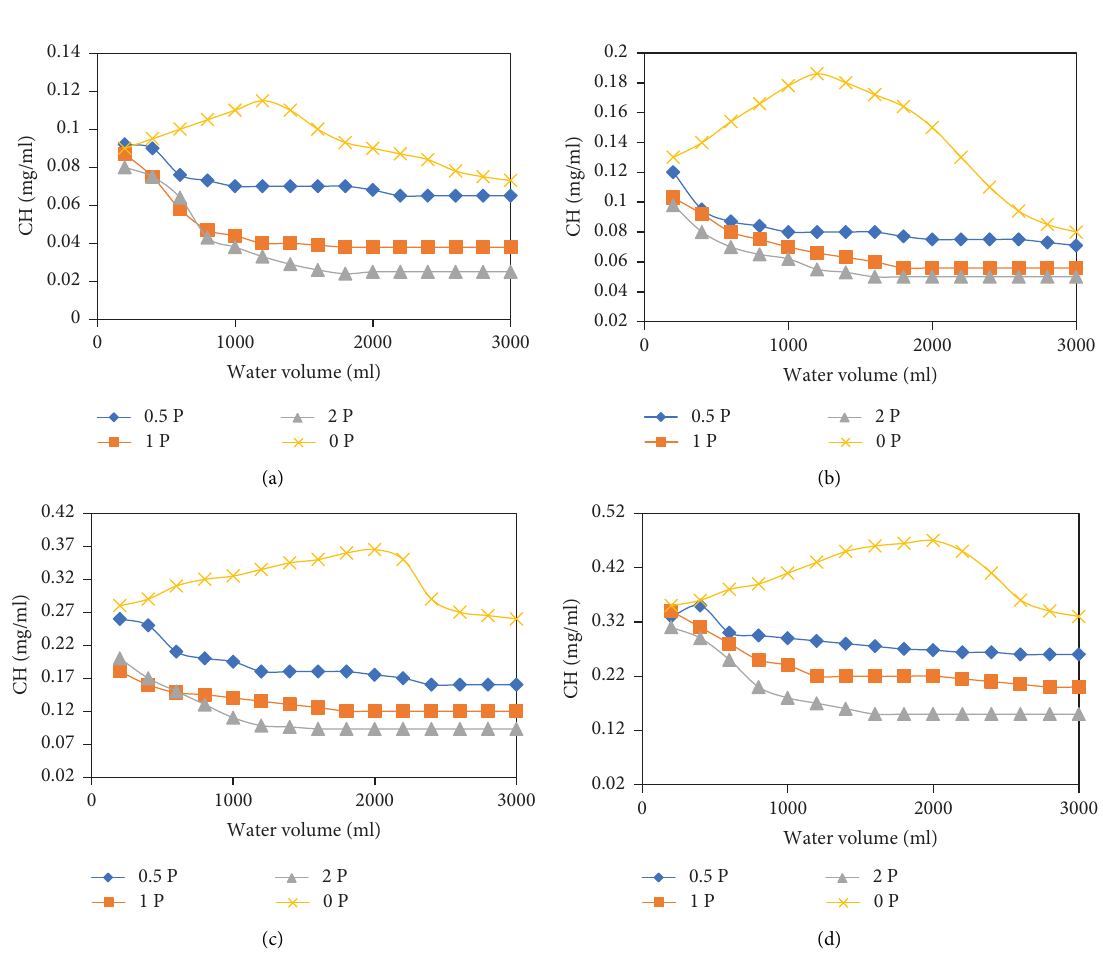
Figure 8: CH-leachate water change of soil samples with pectin for (a) soil 1, (b) soil 2, (c) soil 3, and (d) soil 4.